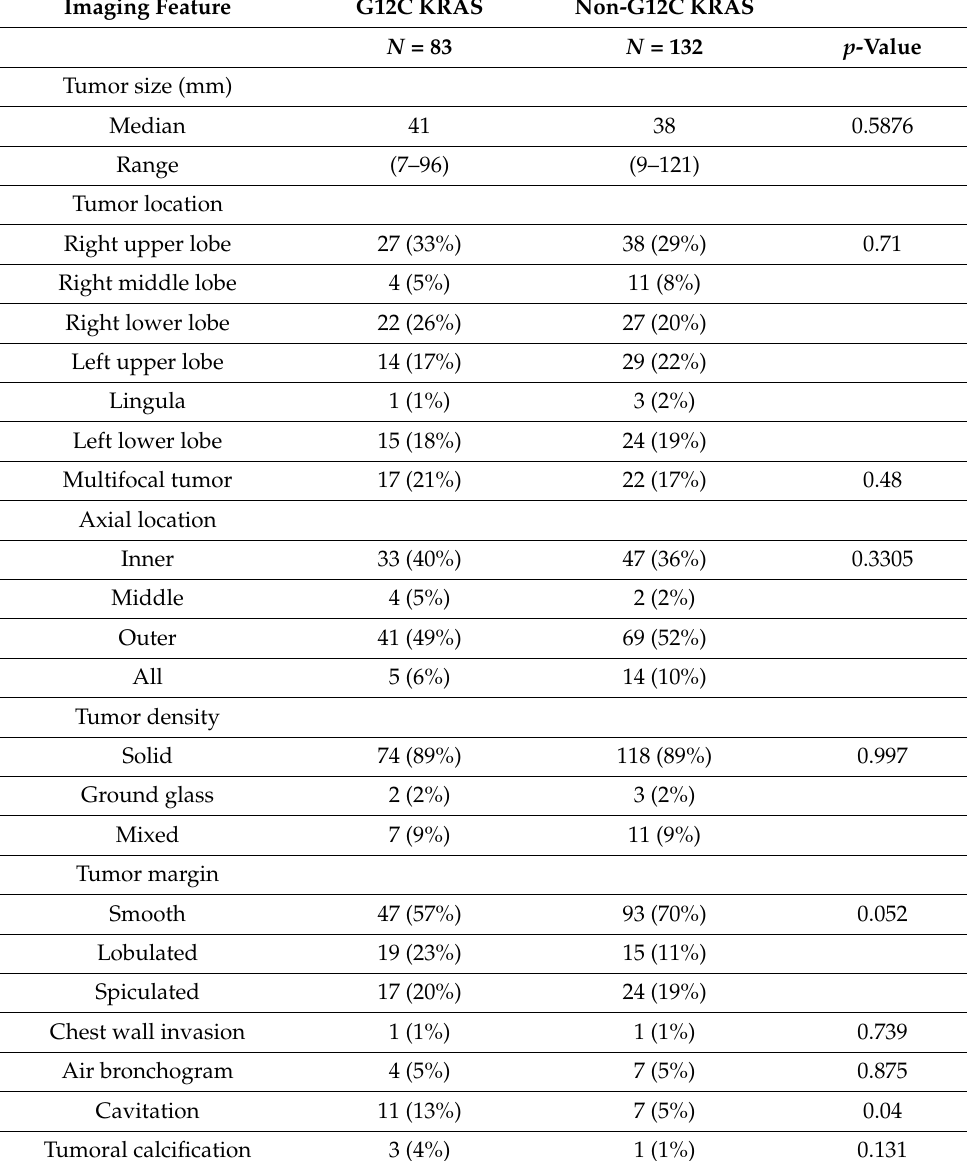
Table 2. Imaging features of primary tumors in G12C and non-G12C KRAS positive